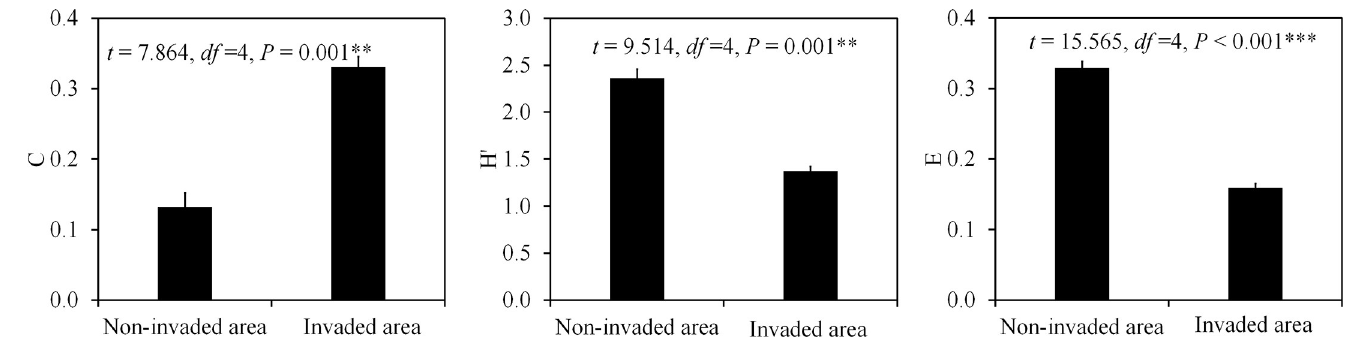
Fig 1. Effect of S . invicta invasion on biodiversity of resident ant species (Independent sample t test, mean ± SE, n = 3 biological replicates). Asterisks indicate significant differences ( ��� P < 0.001). C: Simpson dominance index; H’: Shannon-Wiener index; E: the Pielou evenness index.